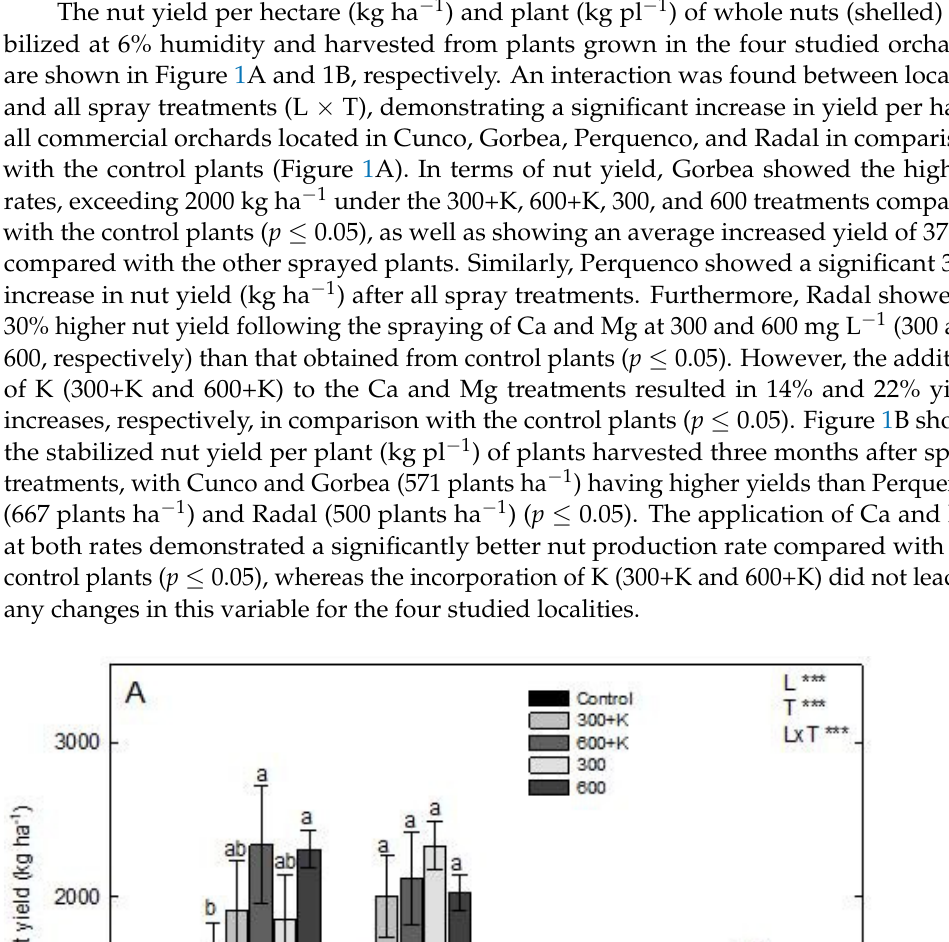
Figure 1. Stabilized nut yield per hectare (kg ha − 1 ) ( A ) and per plant (kg pl ‒ 1 ) ( B ) in TDG hazelnut after the foliar spraying of Ca, Mg and K in four orchard localities in the La Araucanía region. Bars represent the average of four replicates ± S.E. Different letters indicate statistical differences ( p ≤ 0.05) between treatments in the same locality. Two-way ANOVA results are shown; NS: not signif- icant; *** p < 0.001. Control (water), 300+K (Ca+Mg+K at 300 mg L ‒ 1 ), 600+K (Ca+Mg+K at 600 mg L ‒ 1 ), 300 (Ca+Mg at 300 mg L ‒ 1 ), and 600+K (Ca+Mg at 600 mg L ‒ 1 ). 2.2. Nut, Shell and Kernel Traits Table 1 describes the commercial traits of the harvested hazelnuts (nut, shell and ker- nel) from the studied localities after the spraying of Ca, Mg and K. Industrial components such as nut weight (g), length (mm), width (mm), shell weight (g) and thickness (mm), and kernel yield (%) were measured in stabilized nuts. Regarding nut weight, under all